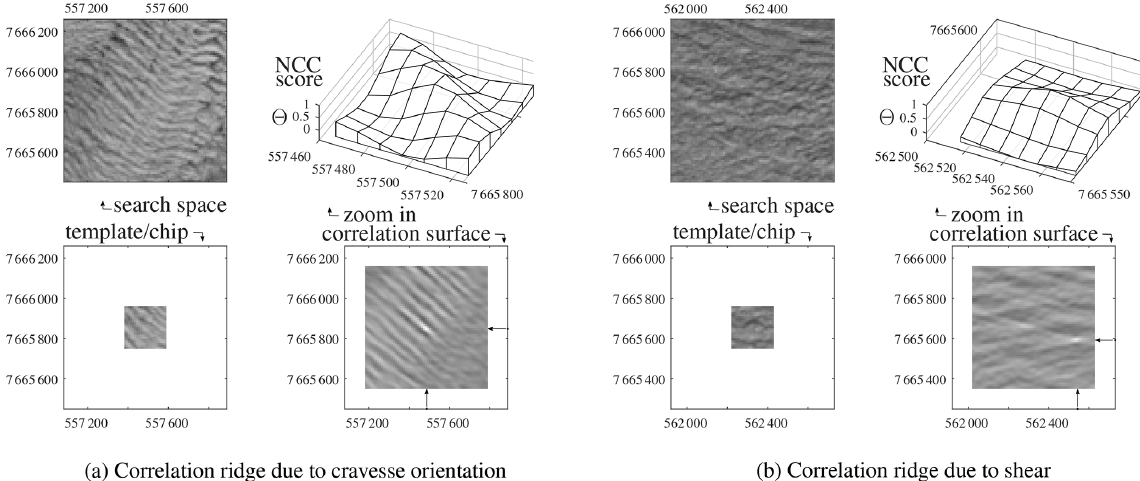
Figure 1. Examples of cross-correlation results with anisotropy, due to the image content or the underlying surface flow. For both panels, the lower-left panel is the image template to be correlated with the upper-left search area. The resulting correlation surface is displayed in the lower right, and a zoom around the correlation peak is in the upper right. Both examples (a) and (b) show typical glacier surfaces that result in elongated correlation peaks (here called correlation ridges), sharply defined in one direction but weakly in the perpendicular direction. NCC: normalized